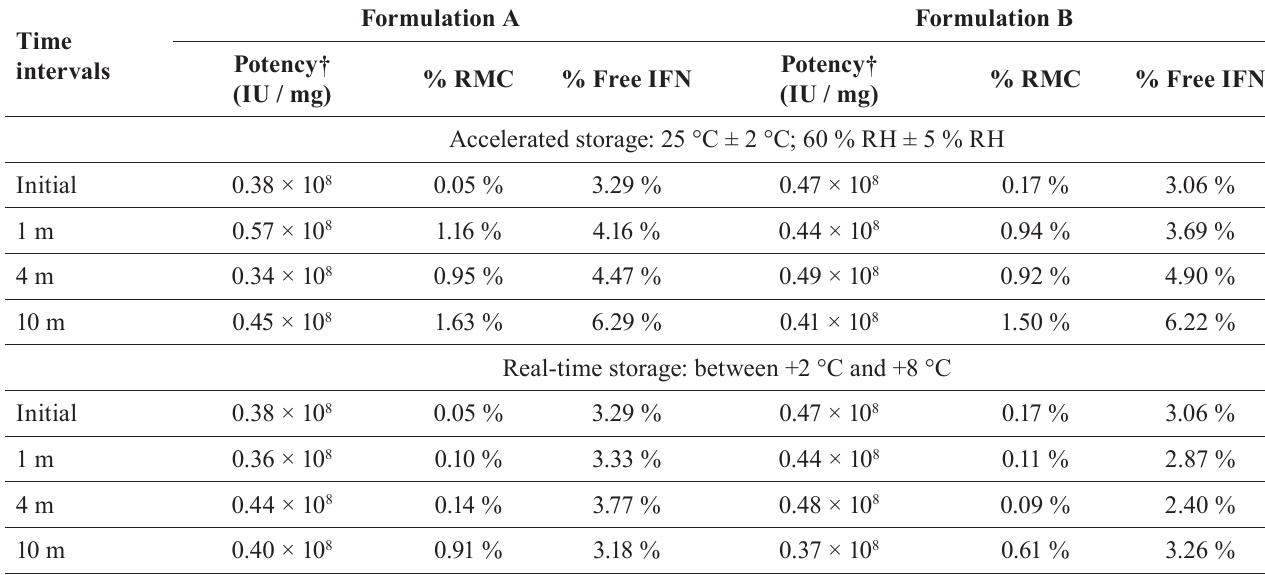
Formulation A: Buffering components – sodium phosphate, Formulation B: Buffering components – sodium succinate; All the samples were found clear colorless upon reconstitution; IFN – Interferon alfa-2; †measured by in-vitro antiviral assay (Range: 0.1 to 0.9 × 10 8 IU